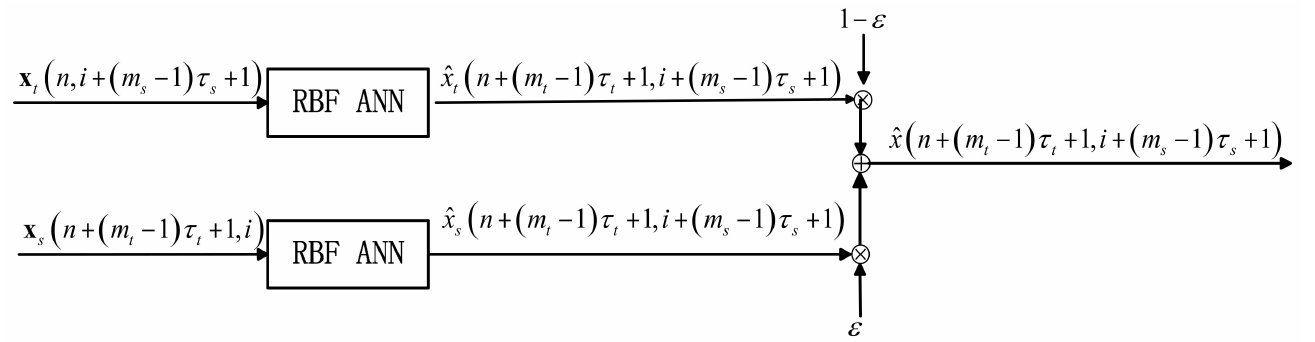
Figure 5. Sea clutter estimation in the spatiotemporal dynamical